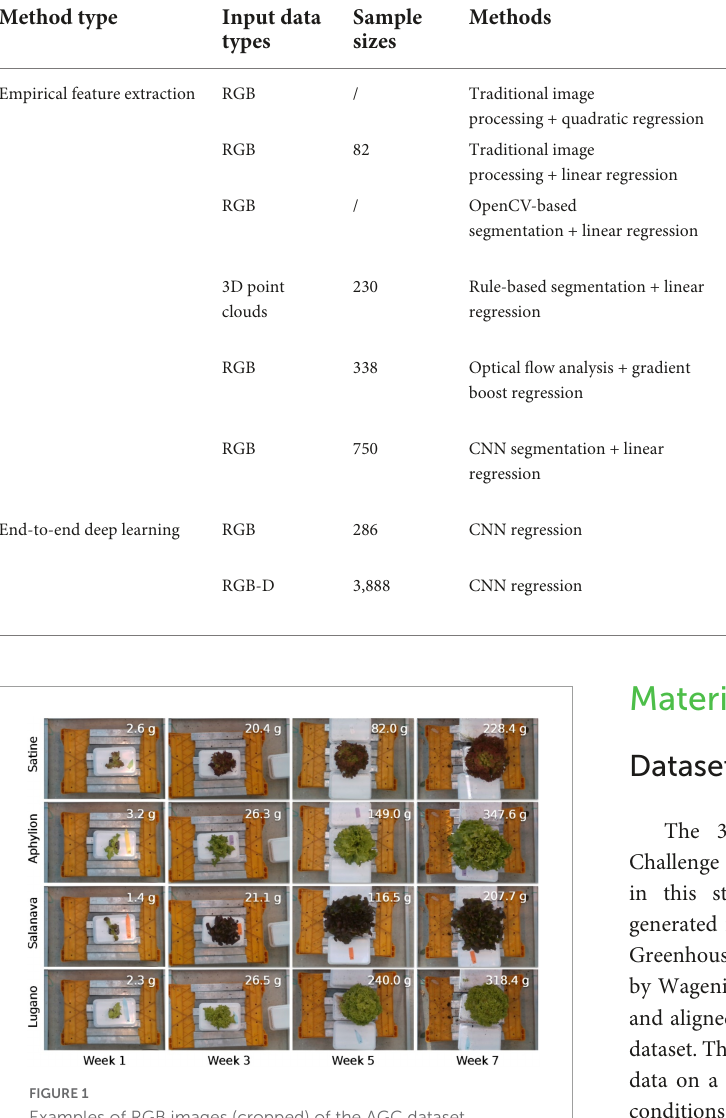
neural features from CNN. A lettuce leaf segmentation network based on U-Net was trained for extracting leaf boundary and geometric traits. A multi-branch regression network was performed to estimate fresh weight by fusing color, depth, and geometric features. Specifically, the objectives of the study were to (1) achieve an accurate and automatic fresh weight estimation of lettuce by a multi-modal fusion based deep learning model; (2) quantify the benefits of combining geometric traits with deep neural features in improving the model performance; (3) investigate the performance variances of fresh weight estimation for different lettuce varieties in the entire growth